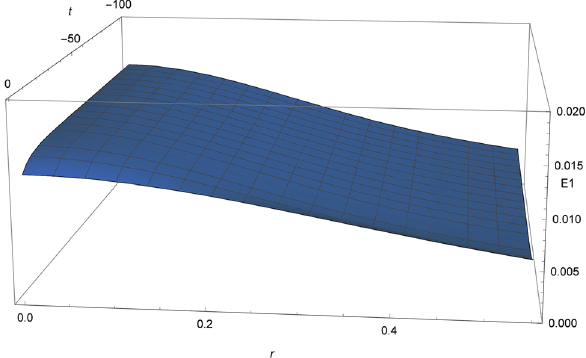
Fig. 7 Energycondition1, c 1 = 0 . 81, c 2 = 0 . 5, c 3 = − 10, c 4 = − 10, ζ = − 0 . 2, R = 6 . 62, r = 0 . 55 and (cid:7) = 0 . 1 0